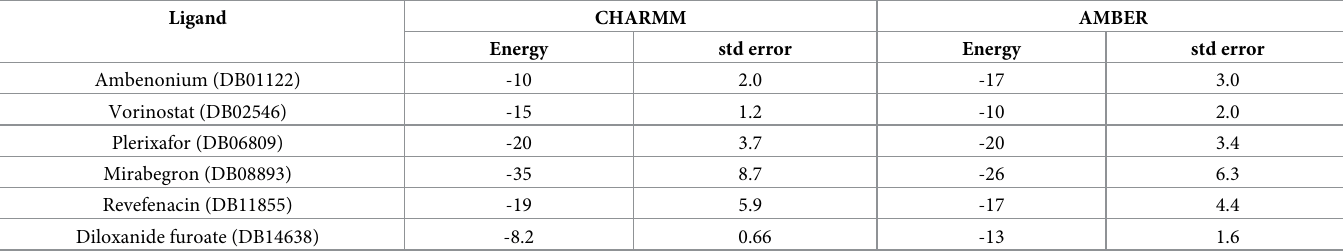
Table 4. Relation between calculated energies with CHARMM and AMBER. The energies described are in kcal.mol -1 . Ligand